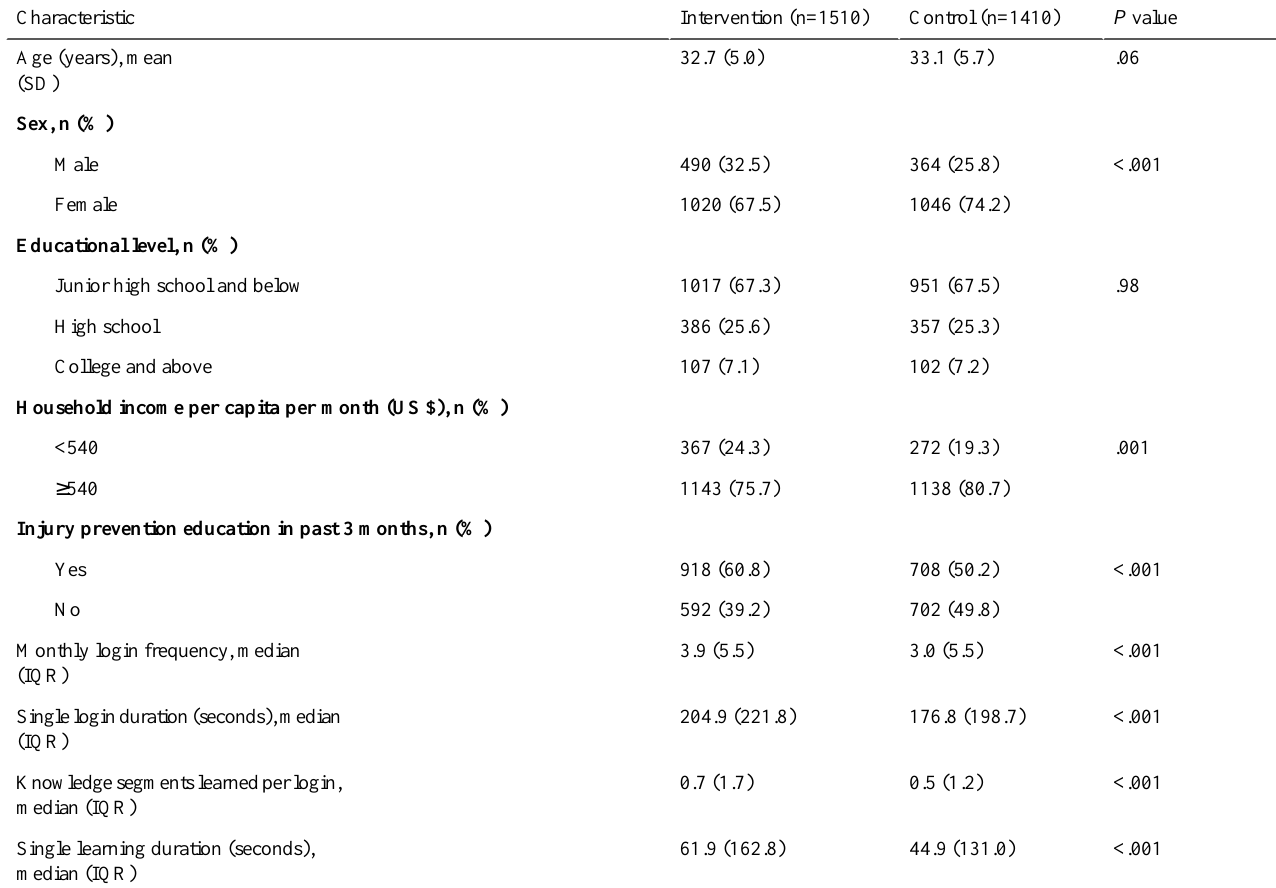
Table 1. Demographic and engagement characteristics of study